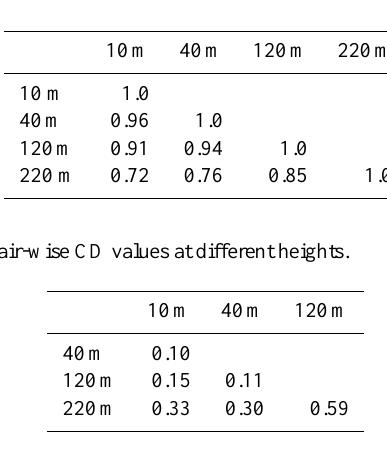
Table 1. Height-to-height correlation coefficient of PM 10 concen- tration.